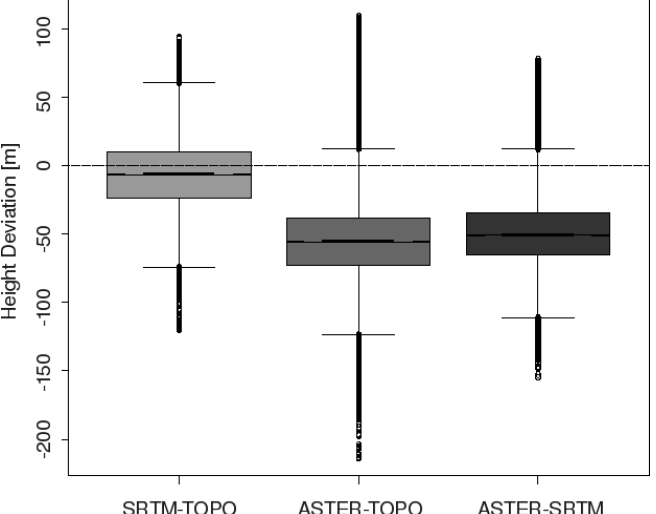
Figure 4. Elevation differences at 20-m spatial resolution between SRTM, ASTER and TOPO DEMs.